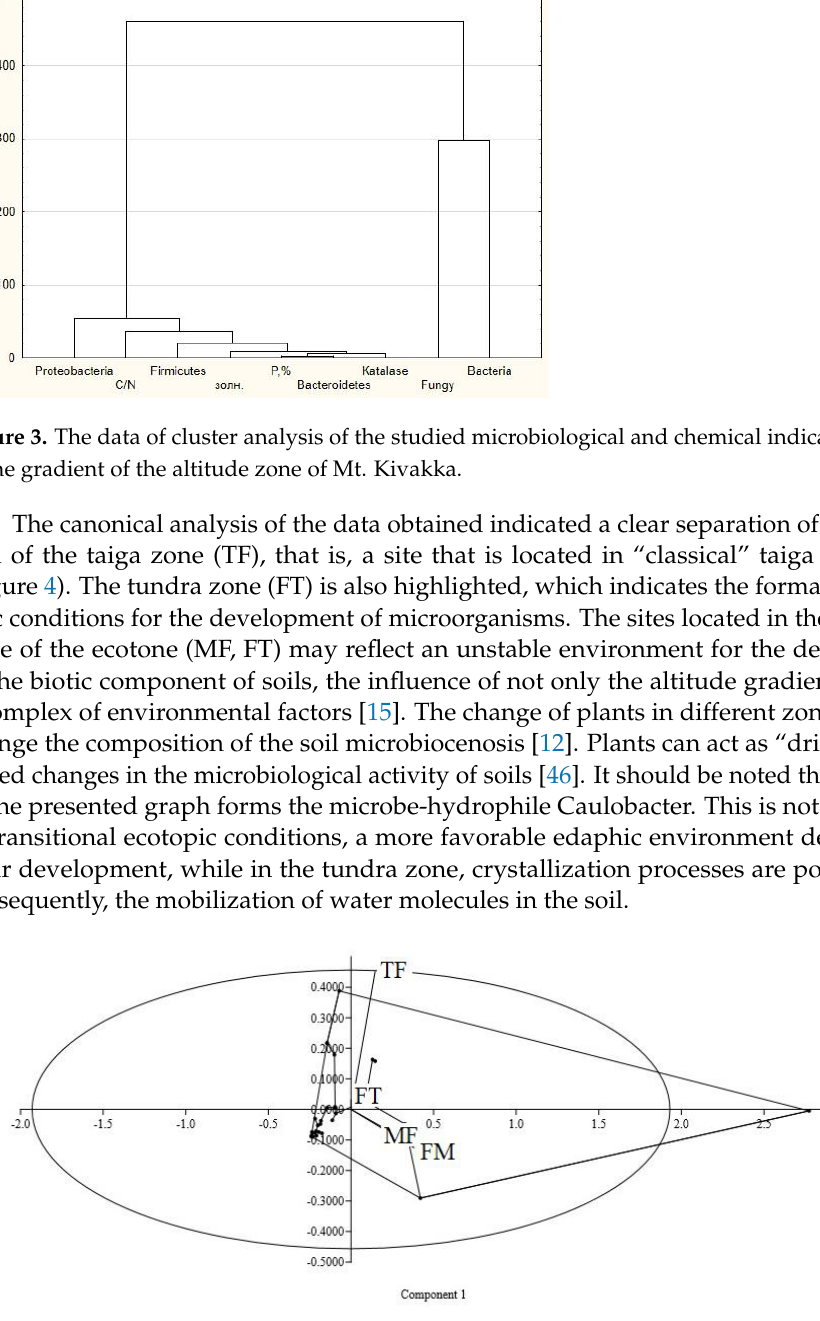
Figure 4. Canonical correspondence analysis of the associations between different form of microor- ganisms and location of soils.